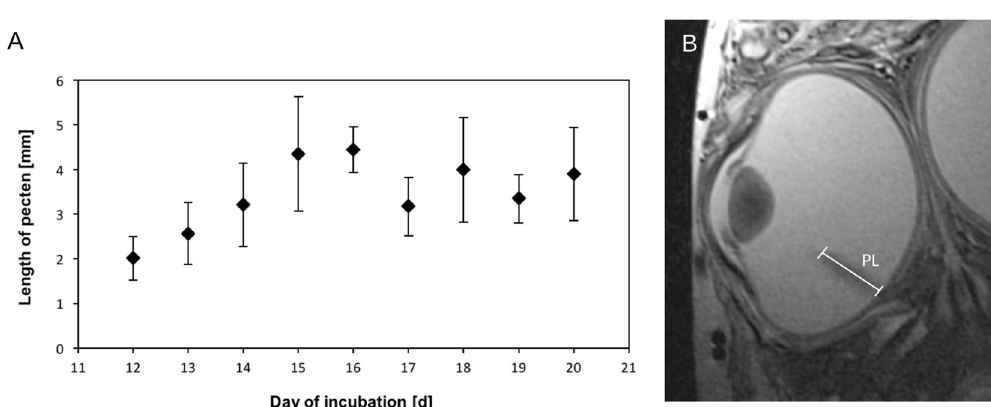
Figure 8. ( A ) Graph showing pecten length from E12 to E20. ( B ) Example to illustrate MRI measurement of pecten